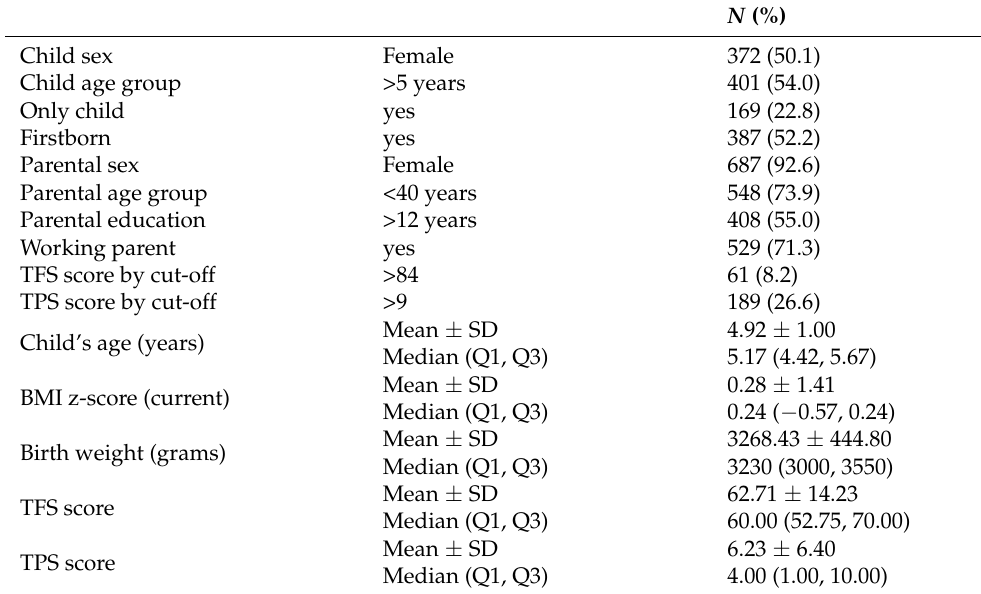
Table 2. Demographic and anthropometric characteristics of the sample and BPFAS